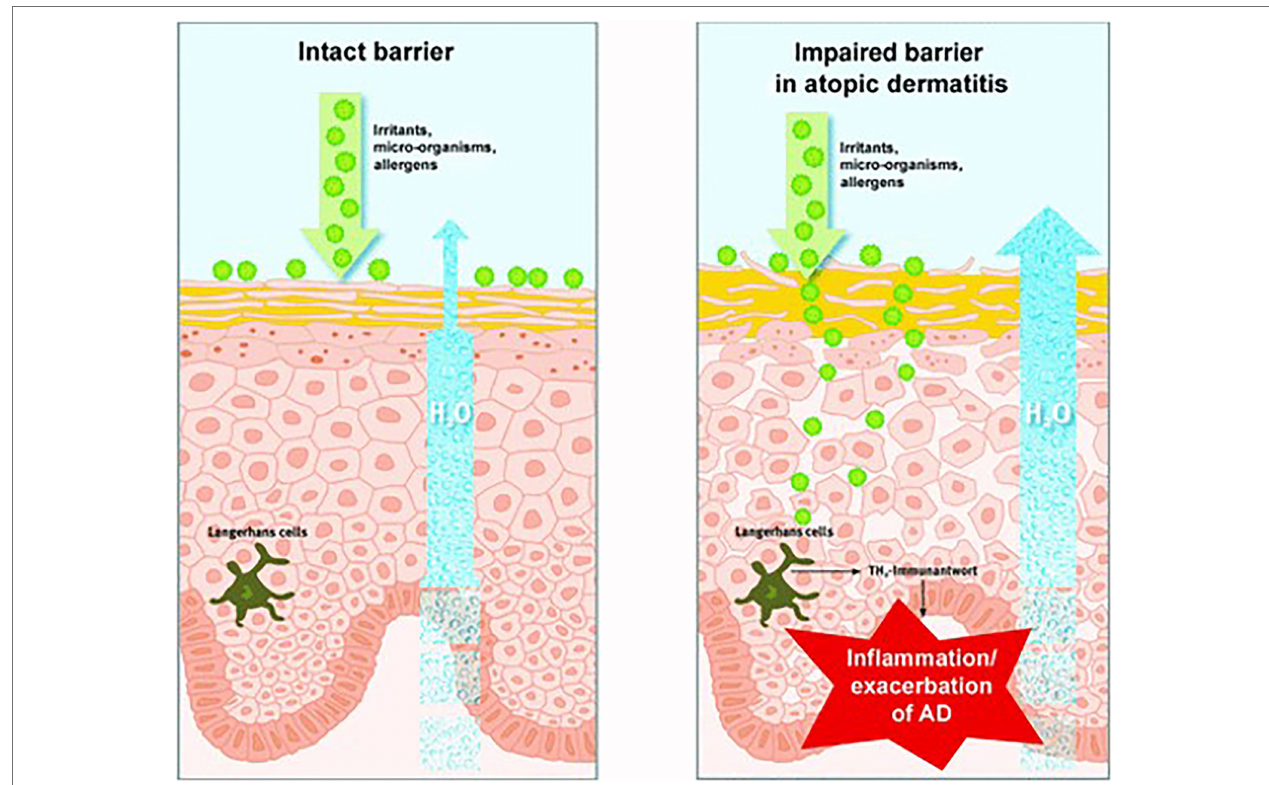
FIGURE 4 | Reprinted with the kind permission of Journal der Deutschen Dermatologischen Gesellschaft publications (Proksch et al., 2009). The skin barrier is normal (left) and impaired (right). When the skin barrier is compromised, water loss increases, and environmental toxins can penetrate the skin, triggering irritation, allergic reactions, inflammation, or exacerbation of specific